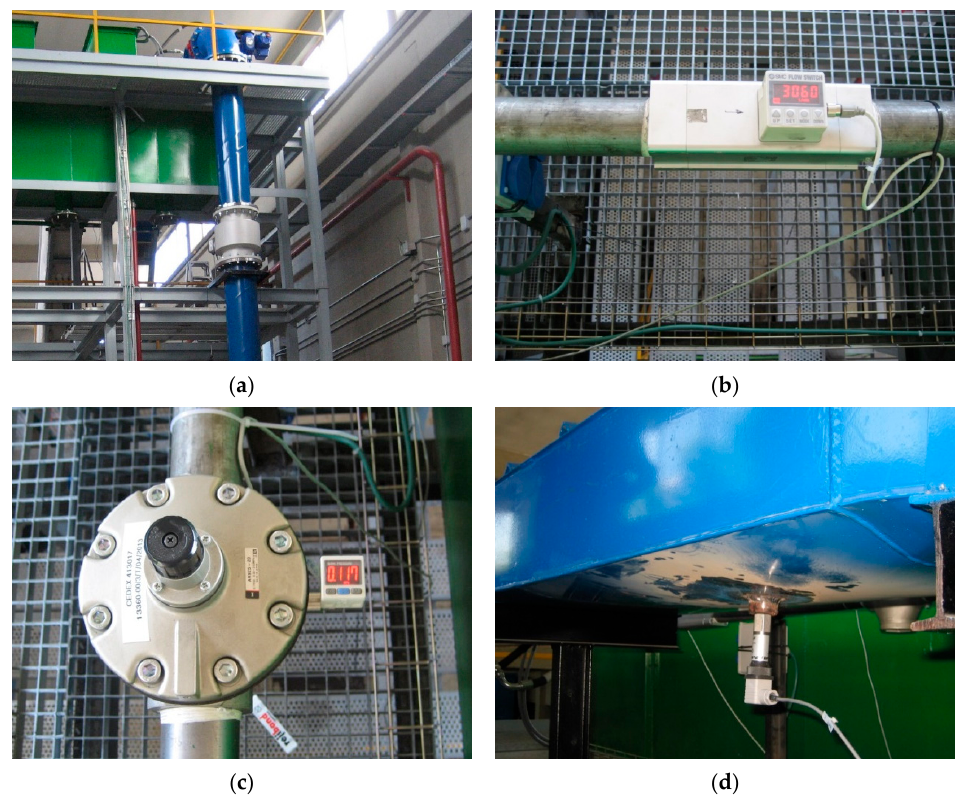
Figure 4. Control devices: ( a ) Water electromagnetic flowmeter; ( b ) Air flowmeter; ( c ) Air pressure control; ( d ) Atmospheric pressure sensor in mixture